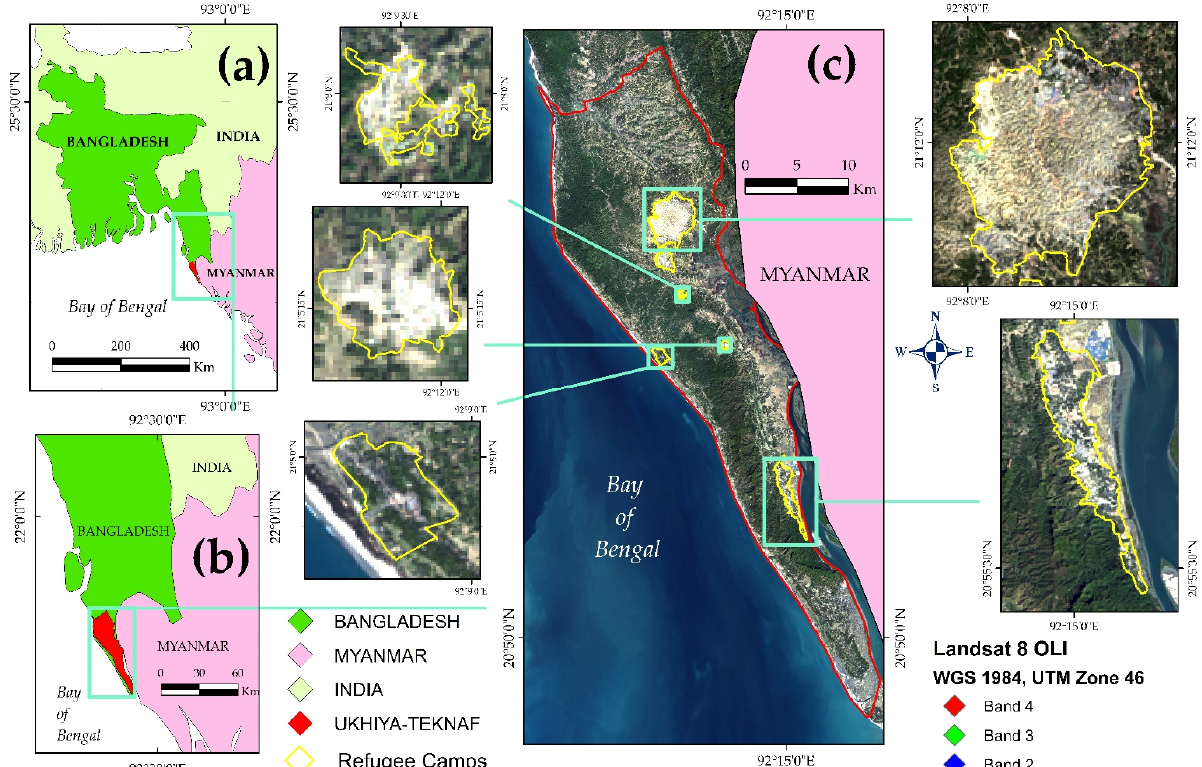
Figure 2. A schematic framework of Ukhiya-Teknaf, study area. ( a ) shows Bangladesh bordered by India, Myanmar, and the Bay of Bengal. ( b ) displays the Ukhiya-Teknaf sub-district, represented as red color, bounded by the Ramu sub-district on the north, Arakan state of Myanmar and Naikhongchori sub-district of Bangladesh on the east, and the Bay of Bengal on the west and south corner. These two-adjoining sub-districts are the focus of our analysis of temporal vegetative cover monitoring before and after the Rohingya refugee crisis and eventually identifies the influencing factors behind the declining vegetative cover. ( c ) shows a natural-color composite image of the study area, Ukhiya-Teknaf, with a band combination of 4, 3, and 2 showing all the existing Rohingya refugee camps dated 4 February 2019. These camps are the focus of our identification and analysis of refugee camps with highly vulnerable vegetative